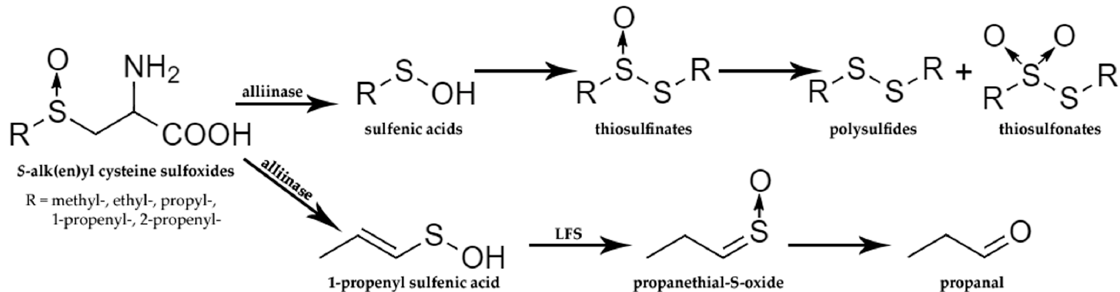
Figure 7. Transformations of cysteine sulfoxides (CSOs) after tissue disruption. LFS—lachrymatory factor synthase based on [61].